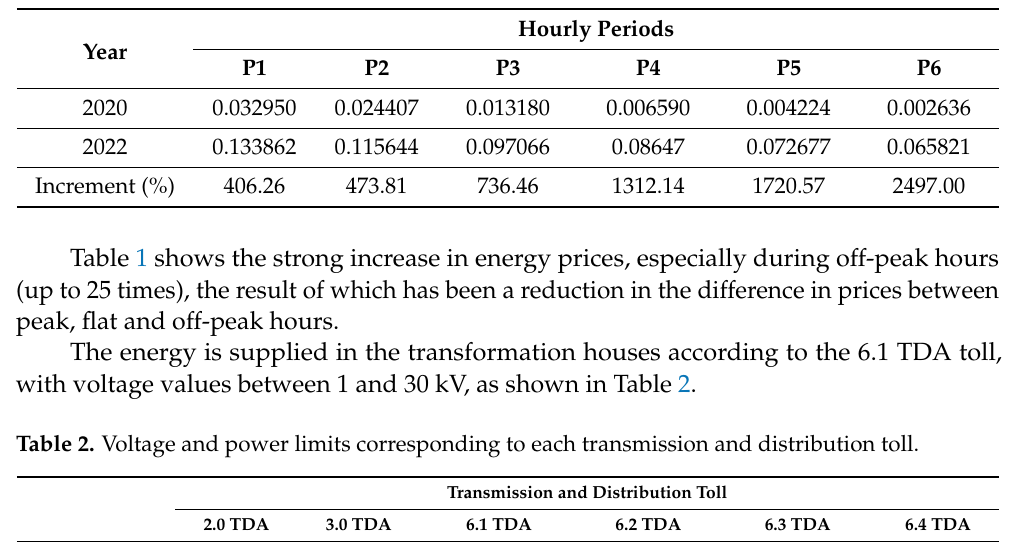
Table 1. Energy prices in Spain ( Te p ), in EUR/kWh, for each hourly period of the 6.1 TDA toll.